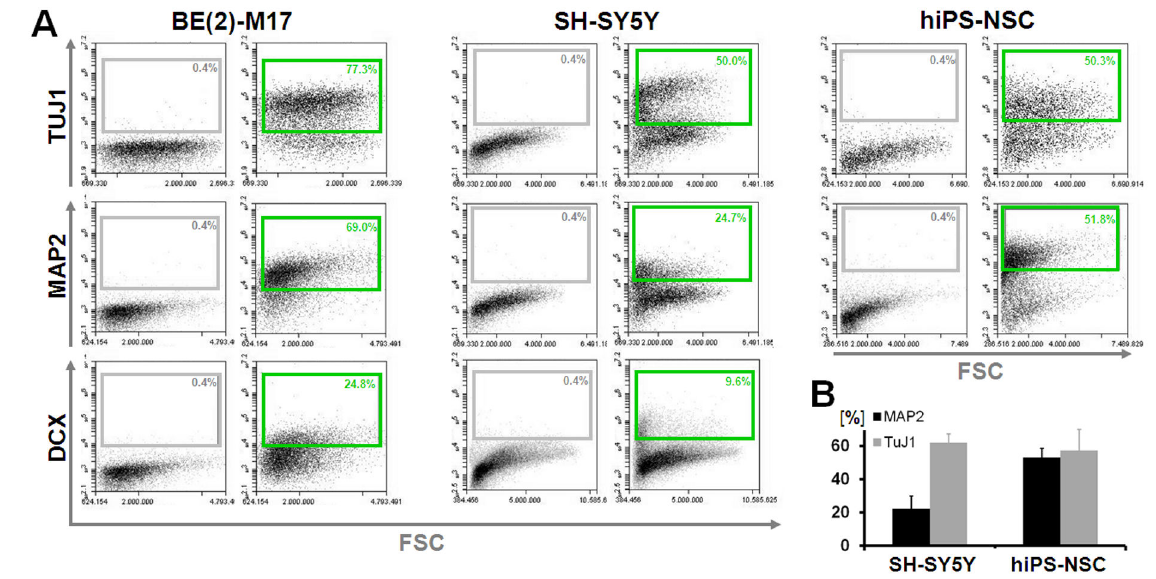
Figure 5. Qualitative and quantitative comparison of intracellular markers expressed by neural cells. ( A ) Flow cytometry for the intracellular antigens TUJ1, MAP2 and doublecortin (DCX) analyzed on various cell sources including neuroblastoma BE(2)- M17 and SH-SY5Y as well as human iPS cell-derived differentiated neural stem cell cultures (hiPS-NSC). Grey boxes in flow cytometry plots specify gates set on negative control samples to capture 0.4%. Green boxes specify positive fraction on stained samples. Error bars in ( B ) indicate standard deviation. doi: